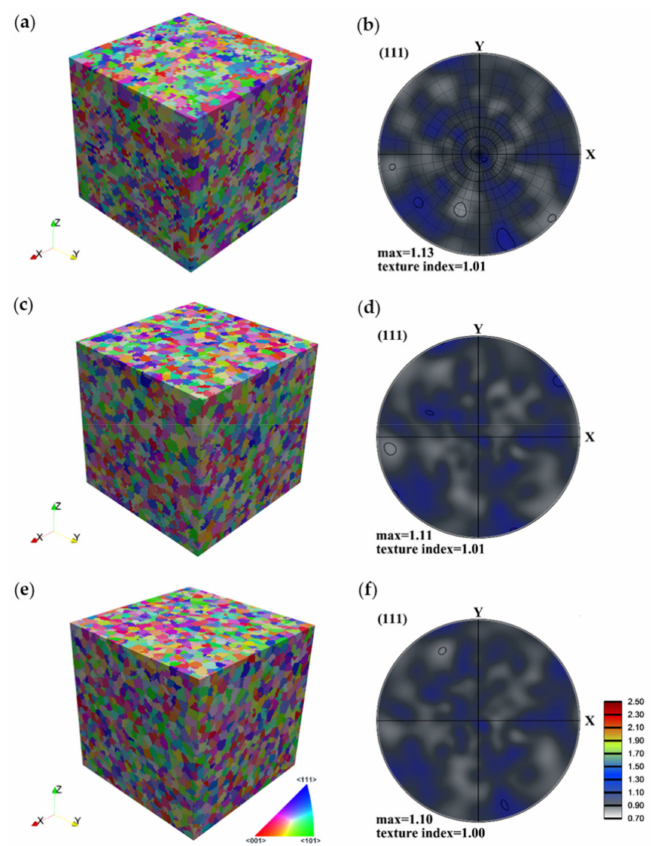
Figure 3. The 3D polycrystal models constructed using the same 10,000 randomly oriented grains: